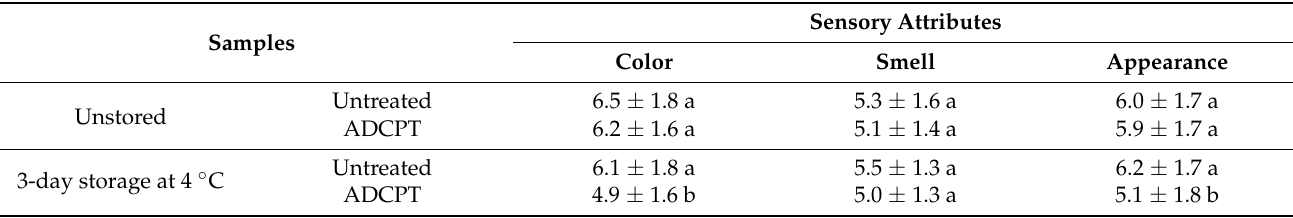
Table 4. Effects of atmospheric dielectric barrier discharge cold plasma (ADCP) treatment at 24 kV for 2 min on sensory attributes of chicken breast